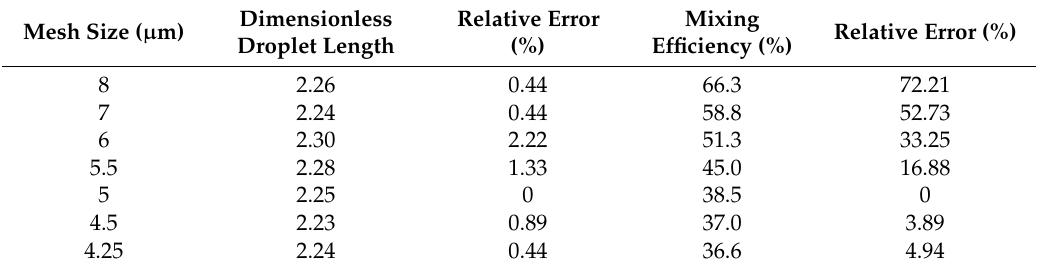
Table 2. Dependency of the dimensionless droplet length and the mixing efficiency to the mesh size. Dimensionless Relative Error Mixing Relative Error Mesh Size ( µ m) Droplet Length (%) Efficiency (%)